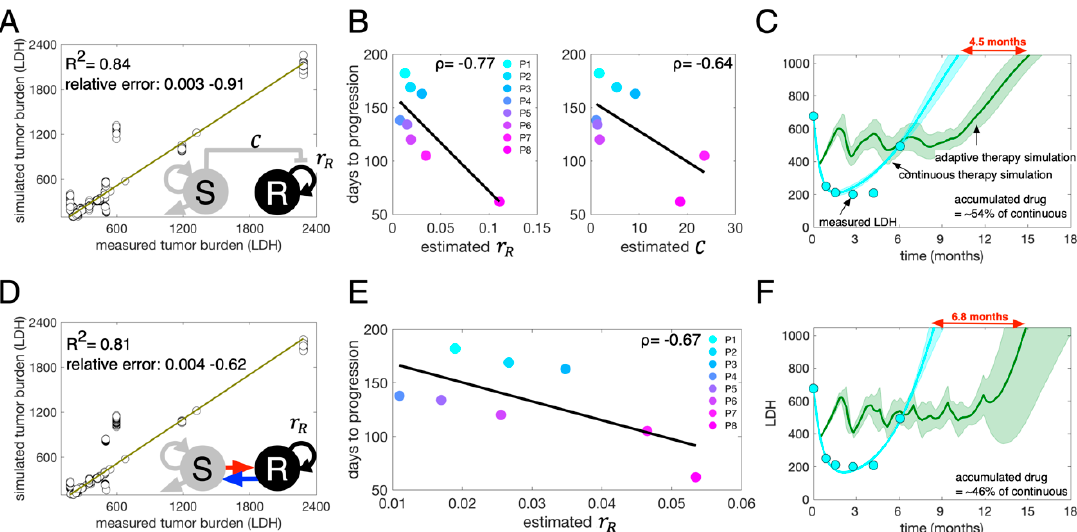
Figure 3. Mathematical model calibration and adaptive therapy simulation. ( A ) LV model fits to the temporal LDH data from eight patients. R 2 = 0.84 when comparing the real patient LDH (horizontal axis) to the simulated tumor LDH (vertical axis). ( B ) Time to progression under continuous therapy is negatively correlated with both the estimated intrinsic growth rate of resistant cells ( 𝜌 = − 0.77) and the competition coefficient ( 𝜌 = − 0.64). ( C ) Adaptive therapy and continuous therapy simulation for patient #1 (P1) using the calibrated LV model. Cyan dots: LDH data of P1, cyan line: LV model fits. Green: predicted adaptive therapy (dark green: mean and shaded region: standard error). ( D ) SW model fits to the temporal LDH data for the eight patients. R 2 = 0.81 when comparing the real patient LDH (horizontal axis) and simulated tumor LDH (vertical axis). ( E ) Time to progression under continuous therapy is negatively correlated with the estimated intrinsic growth rate of resistant cells ( 𝜌 = − 0.67). ( F ) Adaptive therapy and continuous therapy simulation for patient 1 (P1) using the calibrated SW model. Cyan dots: P1 LDH data, cyan line: SW model fit. Green: predicted adaptive therapy (dark green: mean and shaded region: standard error).